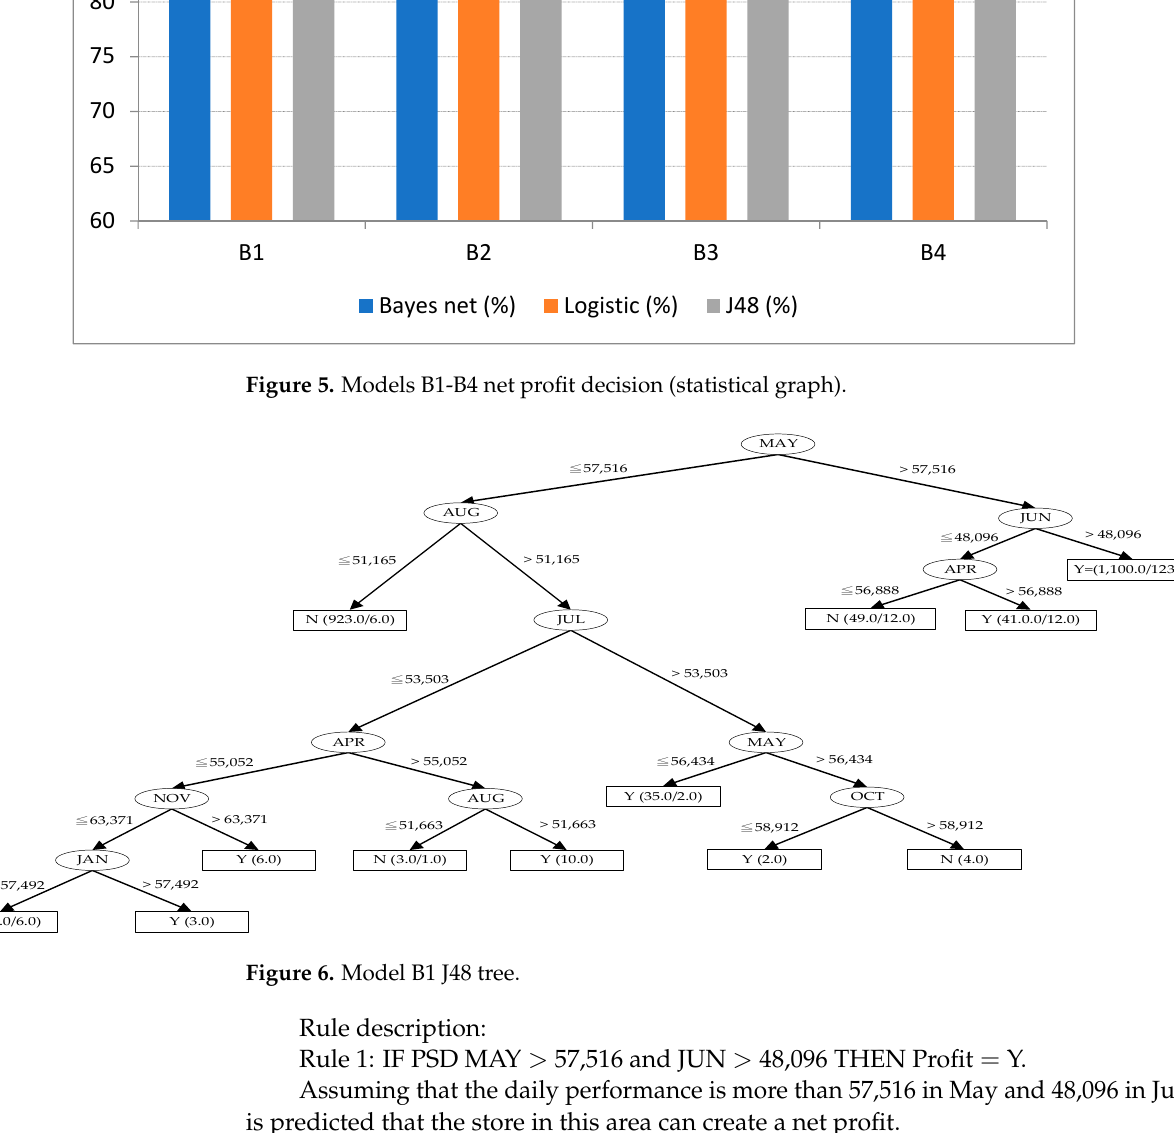
Figure 5. Models B1-B4 net profit decision (statistical graph). Results of Experiment 2: